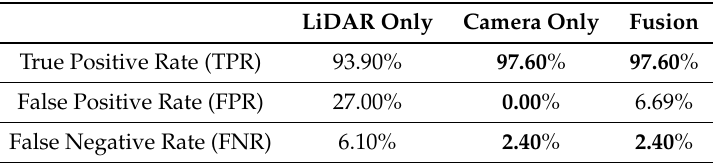
Table 5. Fusion performance: 3 to 20-m range. The best results in bold.